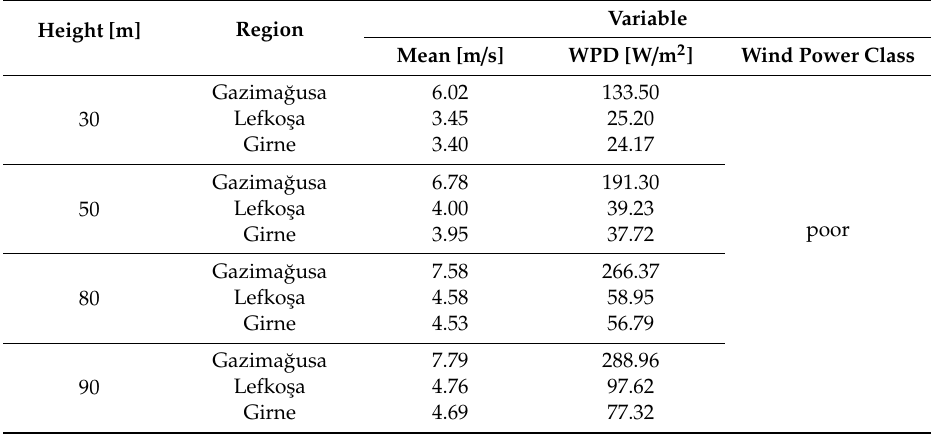
Table 6. The annual wind power density at various